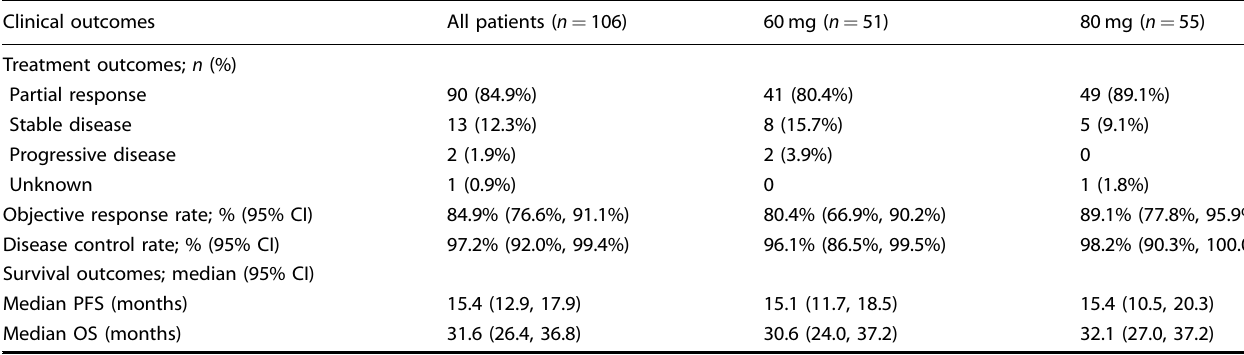
Table 2. Clinical outcomes of the cohort Clinical outcomes